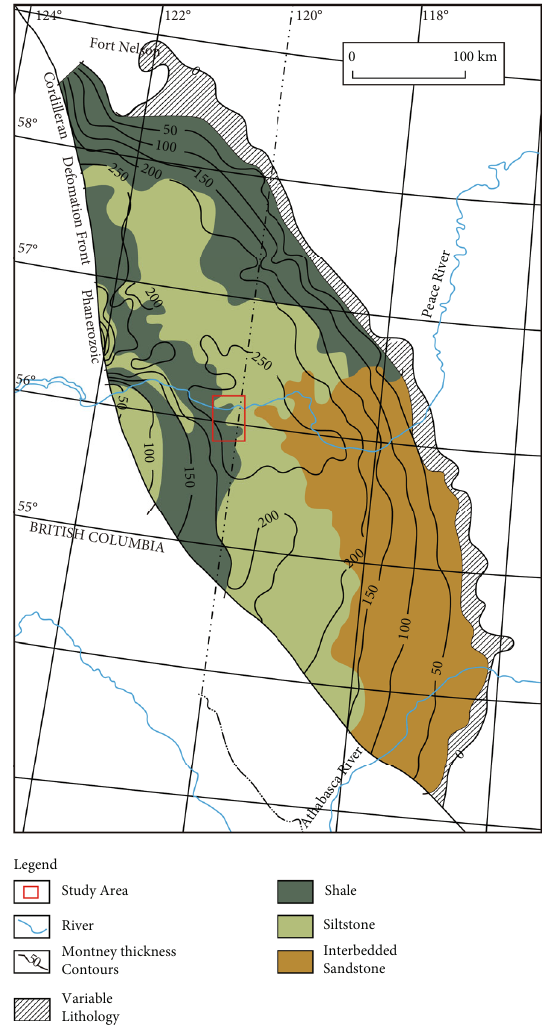
Figure 1: Distributions of the thickness and lithology of the Montney Formation in the WCSB vided into three subunits: the Upper Montney, Middle Mon- tney, and Lower Montney units.